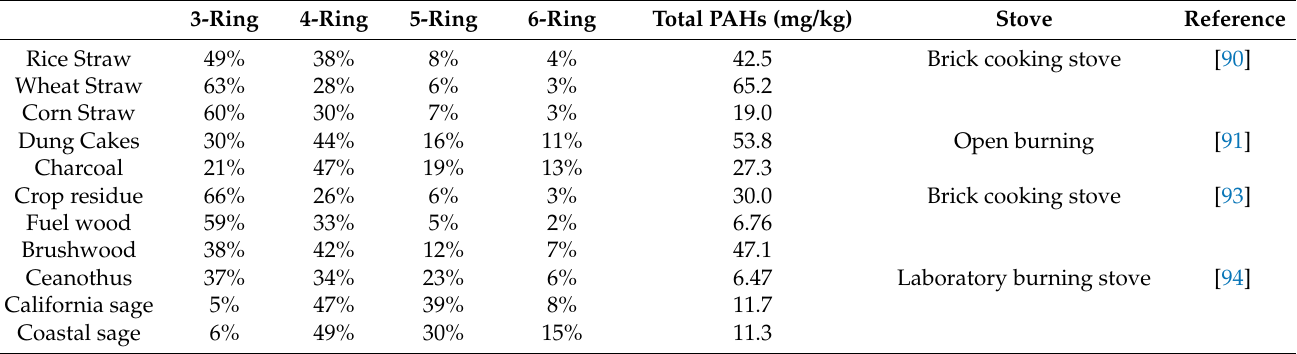
Table 8. Emission factors and composition of PAHs from the burning of different biomass in the same